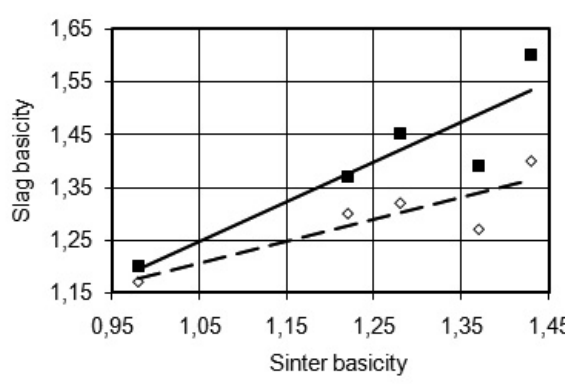
Figure 6. Basicity of the effluent slag ( (cid:2) ) and of the slag